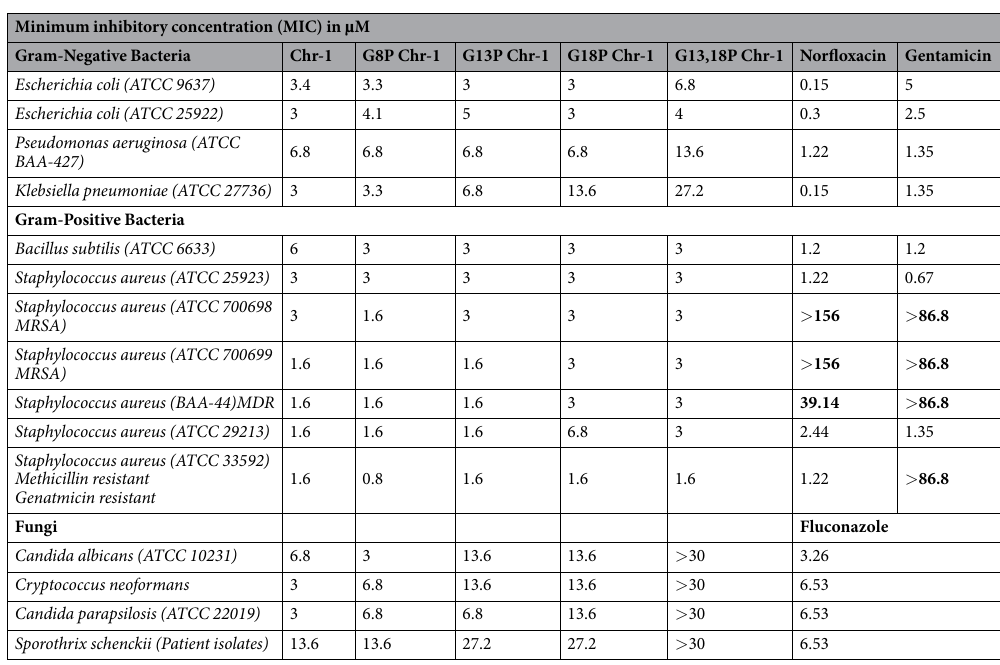
Table 3. Antibacterial and antifungal activity of Chrysophsin-1 and its